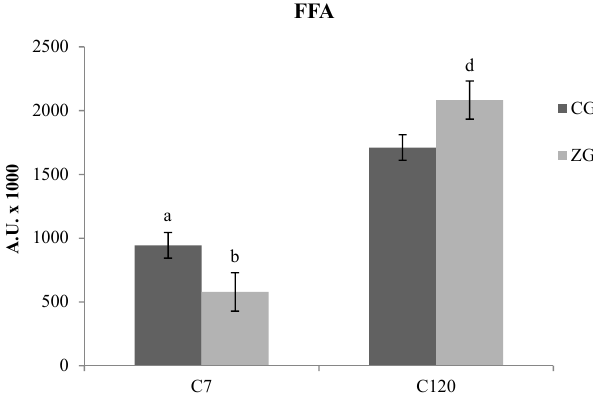
Figure 2. Free fatty acids (FFAs) detected in caciocavallo cheese samples obtained from control group (CG) and zinc group (ZG) after 7 (C 7 ) and 120 (C 120 ) days of ripening. The results obtained after 7 days of ripening, showed a higher concentrations of these compounds in CG samples (dark colored bars) with respect to ZG samples (light colored bars). One hundred and twenty days after the cheese-making, the concentration of FFAs as a whole tends to increase but can be evidenced a reversal of the phenomenon observed at C 7 , with the presence of higher concentrations of FFAs in the ZG samples with respect to the CG samples.